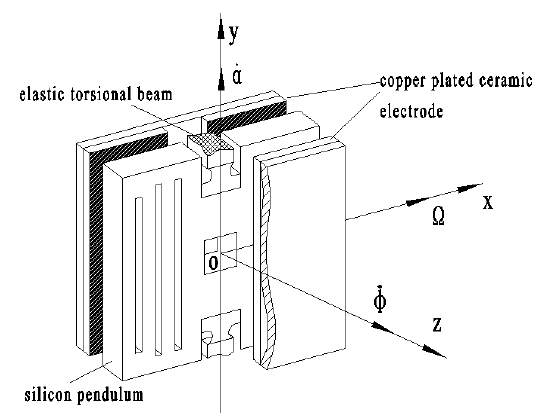
Figure 3. Gyro structure schematic